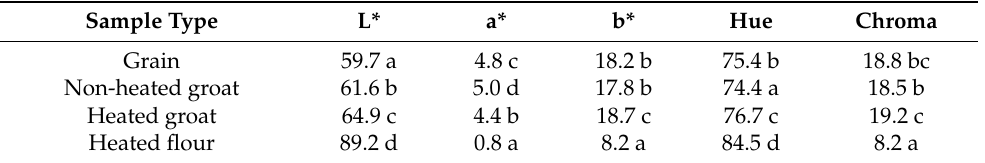
Table 2. Color analysis results of 30 native oat grains, non-heat-treated groats, heat-treated groats and oat flour. The color values are the average values of 30 samples.